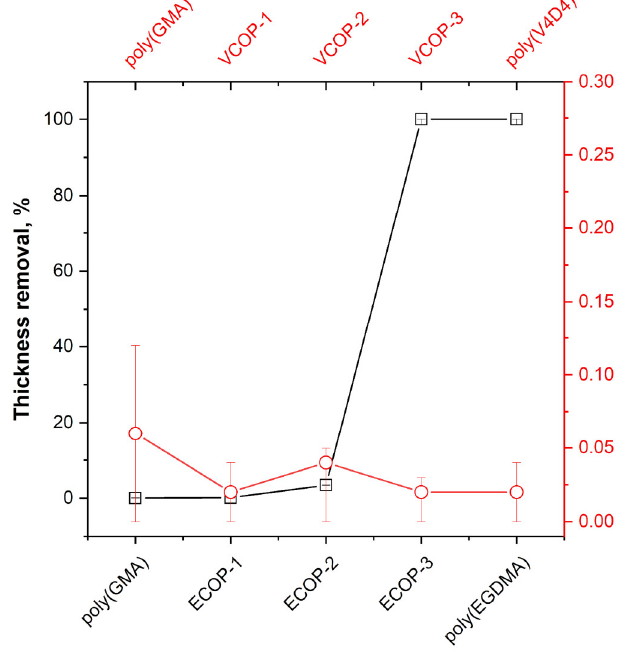
Figure 13. Relative change in film thickness of homo and copolymer coatings after the adhesion test (black squares-poly(GMA), poly(EGDMA) and ECOP copolymers; red circles-poly(GMA), poly(V4D4) and VCOP copolymers).